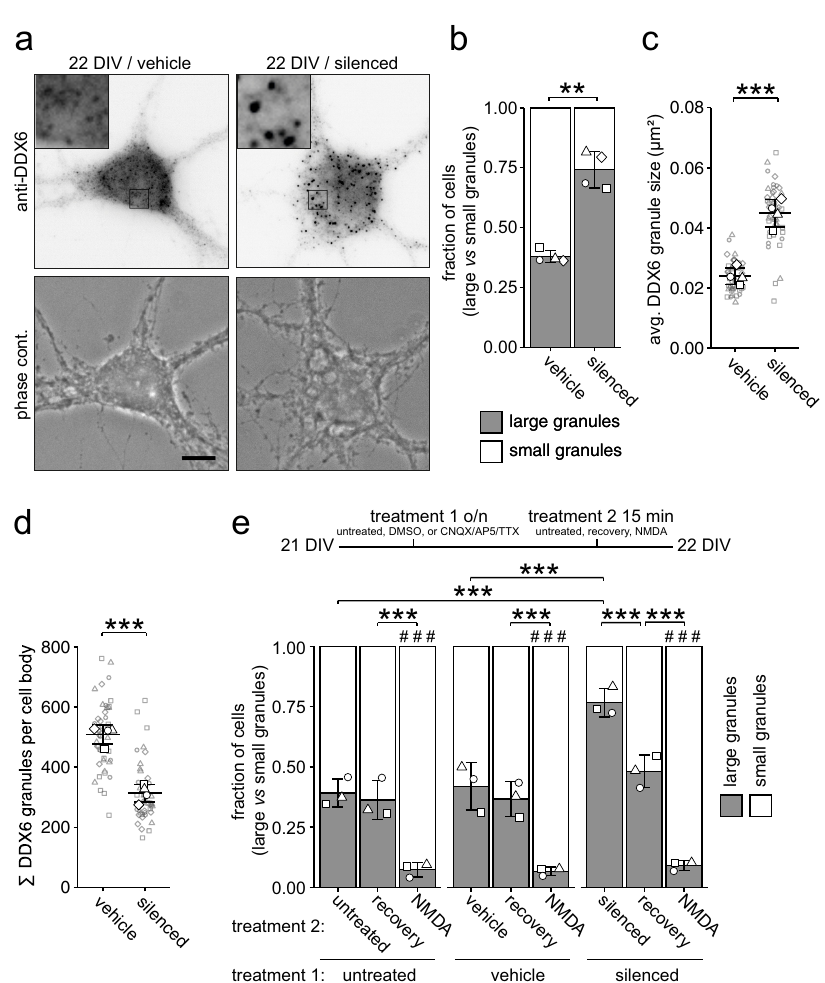
Fig. 2 Chemical inhibition of neuronal activity selectively regulates the assembly of cytoplasmic DDX6 granules in mature hippocampal neurons. a Representative examples of DDX6 immunostainings and phase contrast pictures of 22 DIV hippocampal neurons in culture under vehicle (DMSO) treated or silenced (100 µ M CNQX, 50 µ M AP5, 1 µ M TTX) conditions. Boxed regions in images are displayed as magni fi ed insets. Scale bar 10 µ m. b, e Bar plots displaying quanti fi cation of cell population by fraction of cells containing either large or small DDX6 granules as exempli fi ed in a under untreated, vehicle treated, or silenced conditions ( b , e ), followed by recovery or NMDA treatment ( e ). Experimental outline is presented in e . Data represents mean ± standard deviation of three independent neuronal cultures. Distinct dot symbols indicate biological replicates. At least 100 cells/condition/experiment were quanti fi ed. c , d Dot plots displaying average DDX6 granule size ( c ) and DDX6 granule number ( d ) of individual cell bodies under vehicle treated (DMSO) or silenced conditions. Small gray symbols represent single cells while larger white symbols indicate the average of each replicate. Horizontal line and error bars represent mean of replicates and standard deviation ( n = 4 biologically independent experiments). Asterisks represent p -values obtained by two-sided Student ’ s t -test ( b – d ) or Tukey ’ s test post-hoc to two-way ANOVA analysis ( e ) (** p < 0.01). Hashtags represent p -values obtained by Tukey ’ s test compared to untreated conditions ( e ) (### p < 0.001). p = 0.0012 ( b ), p = 0.00053 ( c ), p = 0.00010 ( d ), F 2,18 = 1.59e-05, treatment 1, F 2,18 = 2.38e- 11, treatment 2 ( e